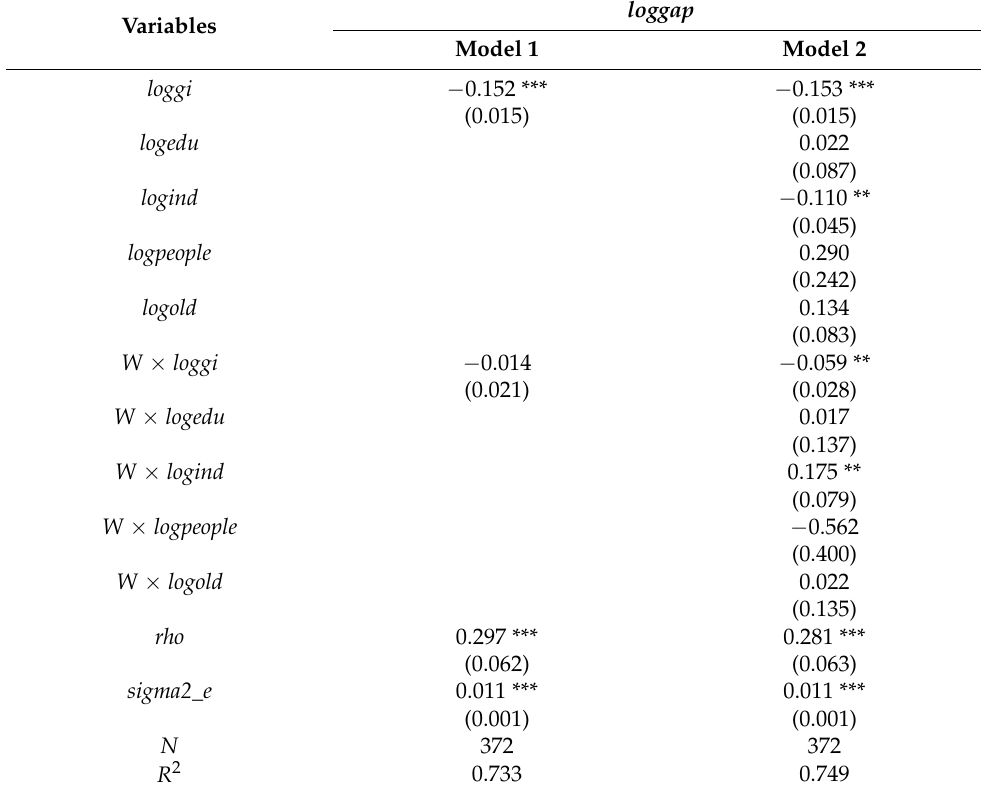
Table 6. Variable regression